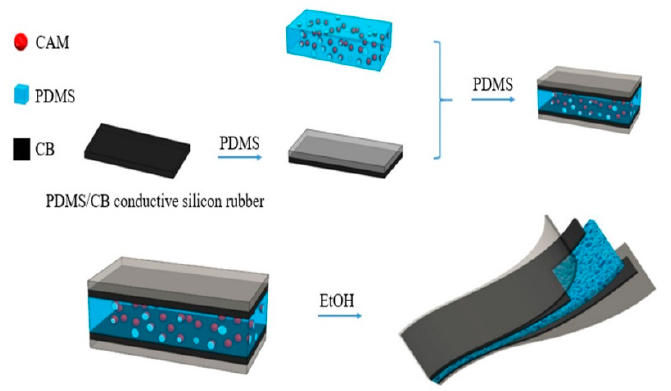
Figure 1. Schematic diagram of the sensor layers and materials, and their